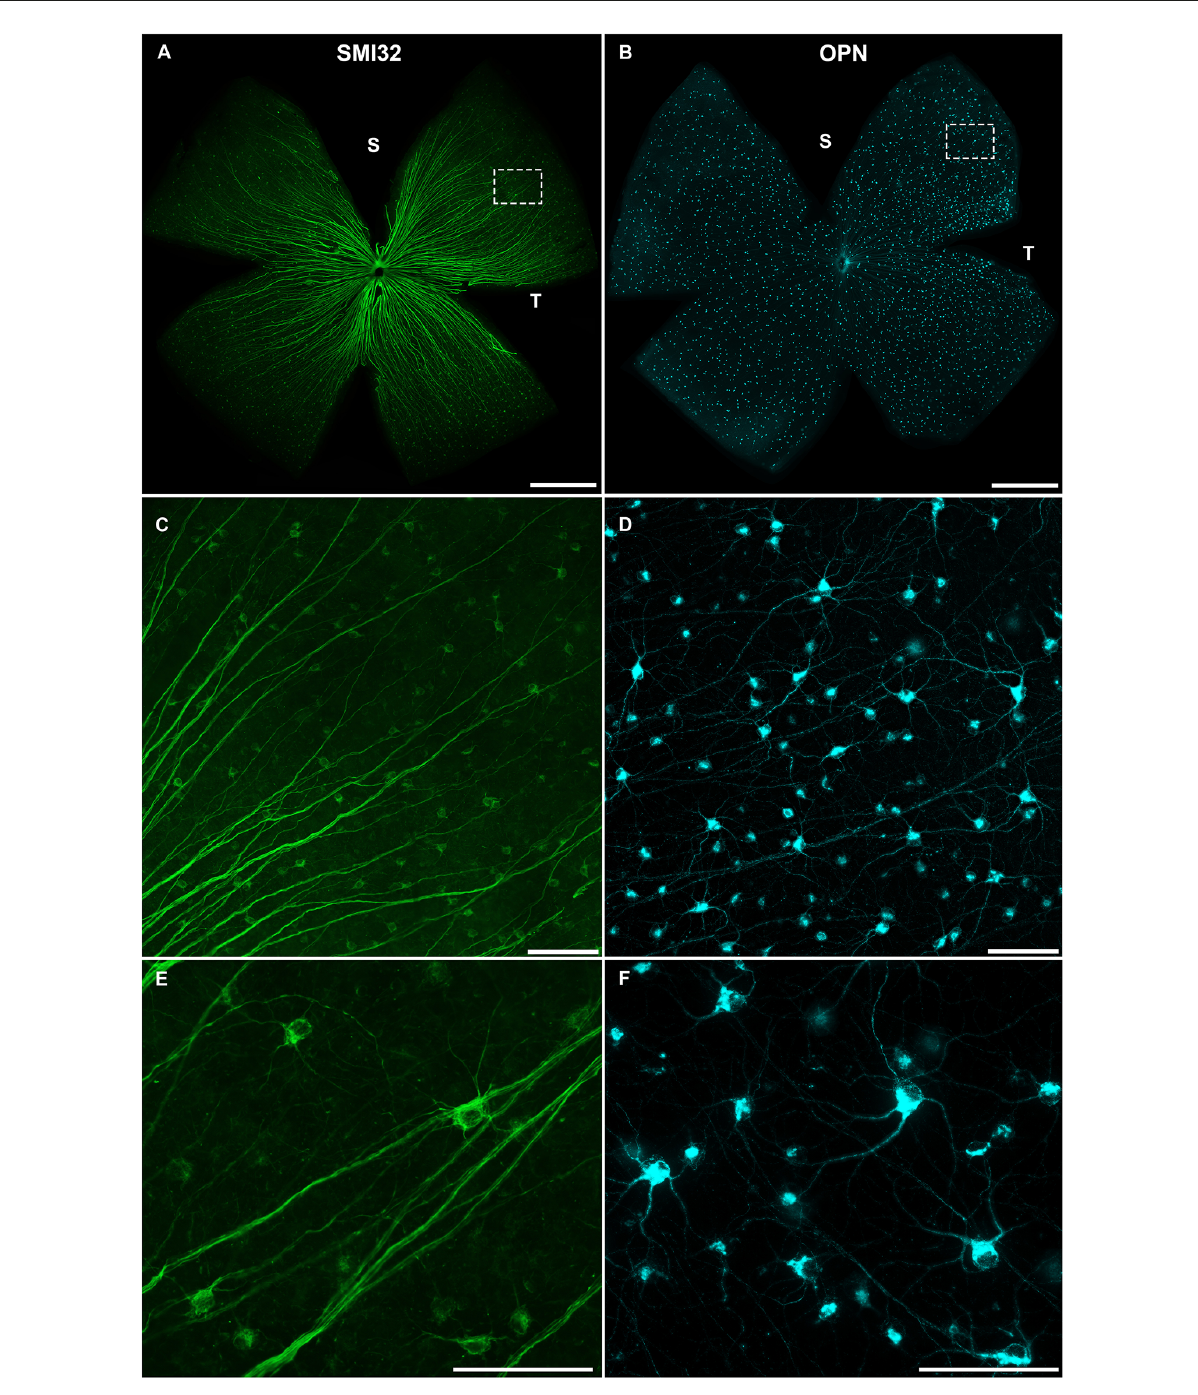
FIGURE2 Representative images of α RGCs immunodetected in flat-mounted retinas against SMI32 or OPN. Photomontages of representative retinas immunodetected against SMI32 (A) or OPN (B) , two pan-markers of α RGCs. 20 × (C,D) and 40 × (E,F) magnifications of flat-mounted retina immunodetected with SMI32 or OPN showing whole-body labeling of stained α RGCs, including soma, proximal dendrites, and axons. Scale bar in (A,B) : 1 mm. Scale bar in (C–F) : 100 µ m. S, Superior; T,